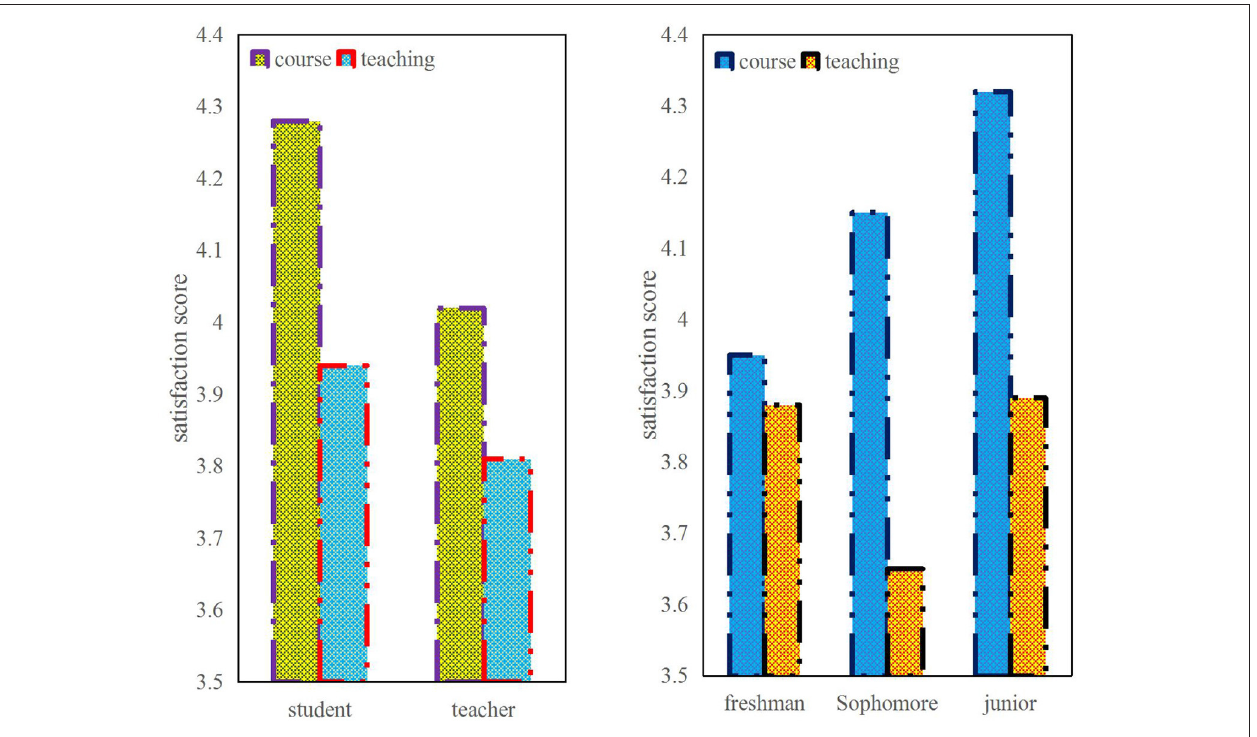
FIGURE 1 | Comparison of different subjects’ satisfaction with curriculum and